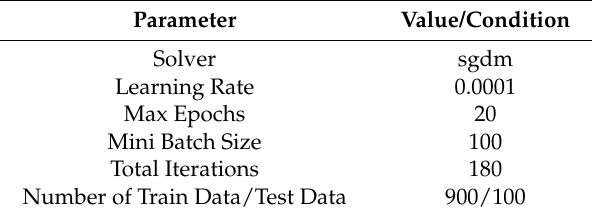
Table 5. Transfer learning settings.